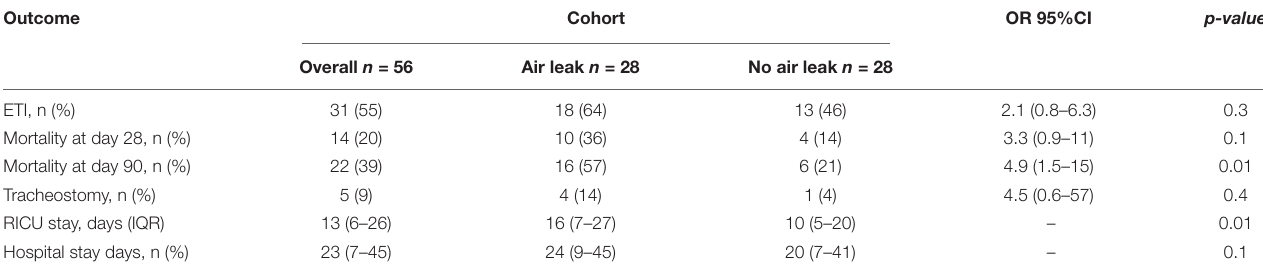
FIGURE 3 | Twenty-eight-day survival analysis of patients with and without air-leak. Kaplan–Meyer analysis for composite outcome ventilator free days at day 28 in patients with and without air leak. Patients with AL presented an increased risk of being dead or still on mechanical ventilation at day 28 by 270% as compared to NAL. Significance was set for p < 0.05. MV, mechanical ventilation; RICU, respiratory intensive care unit; AL, air leak; NAL, non-air-leak. TABLE 2 | Clinical outcomes of the study population presented as a whole and according to the onset of